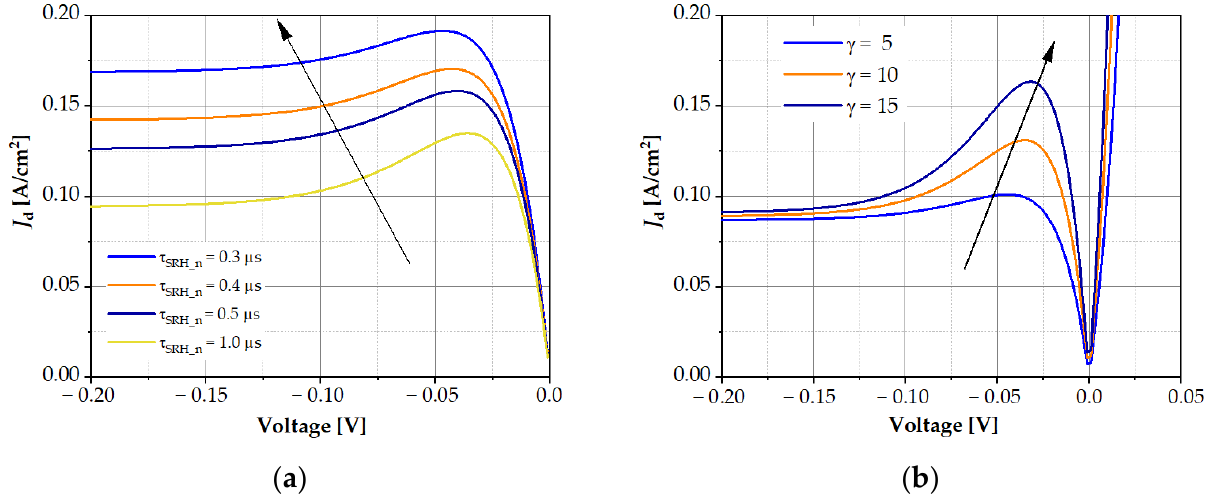
Figure 7. Current–voltage characteristics of the modelled MWIR detector structure: ( a ) for different SRH electron recombination times and ( b ) for different Auger γ parameters.